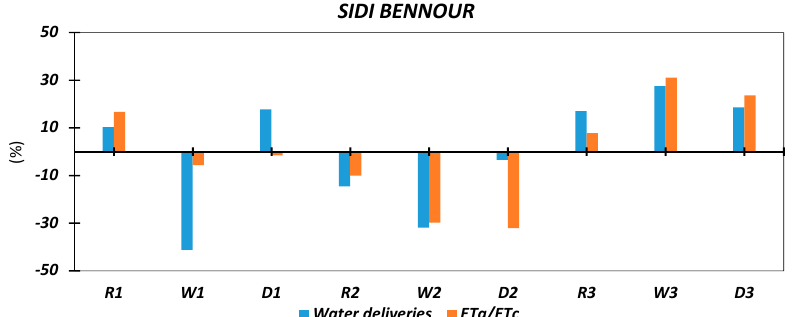
Figure 10. Zemamra district; relative anomalies in quarterly water delivery W d and relative evapotranspiration (ET a / ET c ); 1,2,3 and R, W, D: see Figure 6.